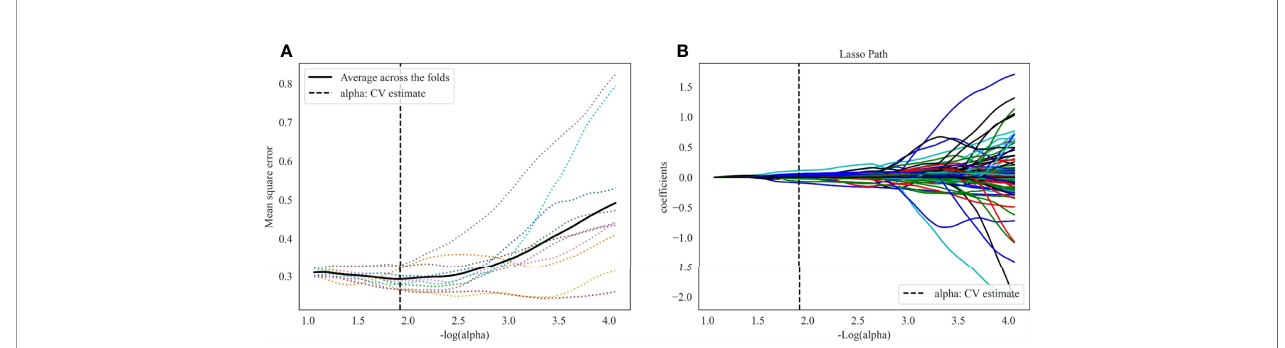
FIGURE 3 | LASSO algorithm for radiomics features selection. (A) Mean square error path using 10-fold cross validation. (B) LASSO coef fi cient pro fi les of the radiomics features.